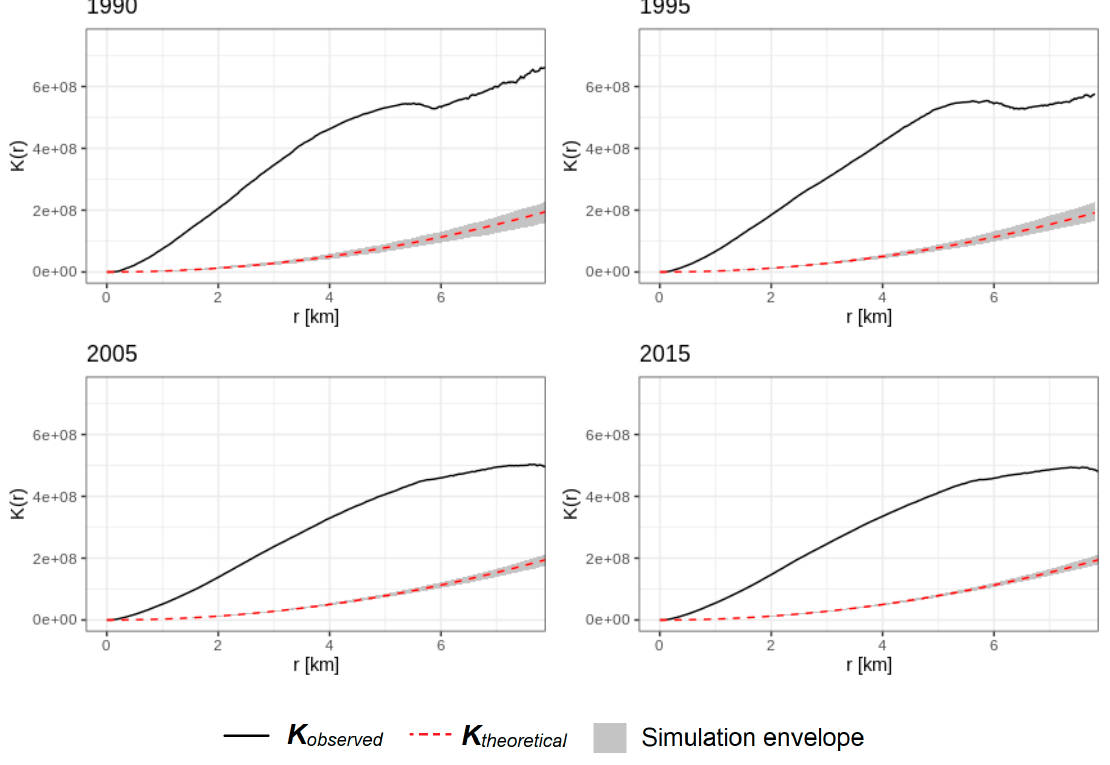
Figure 6. Observed Ripley’s K-function (solid black line) compared to the theoretical K-function (red dashed line). Grey areas denote simulation envelopes from Monte Carlo simulations with 1000 iterations.